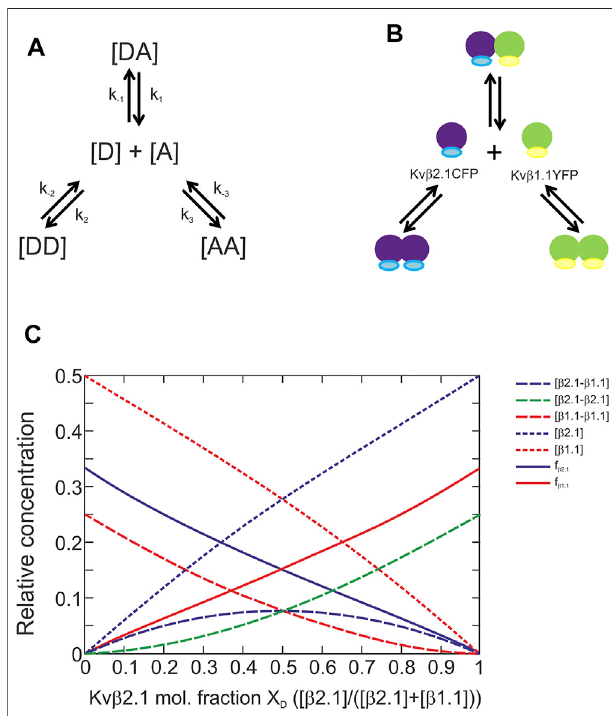
FIGURE 4 | Kv β 1.1 and Kv β 2.1 can form homo- and heteromeric complexes with similar af fi nities. (A) Model of the interaction between donor and acceptor proteins. (B) Model of Kv β 1.1 and Kv β 2.1 oligomerization. (C) . The calculated plotwasbased ontheformula developed intheMATLAB program to fi nd the af fi nity constants. Plot of the different parameters [DA], [DD], [AA], [D], [A], f D and f A depending on the donor molar fraction when a model presents the same af fi nity for forming three different complexes. [ β 2.1 – β 1.1], concentration of donor – acceptor complexes. [ β 2.1 – β 2.1], concentration of donor – donor complexes. [ β 1.1 – β 1.1], concentration of acceptor – acceptor complexes. [ β 2.1], donor concentration, [ β 1.1],